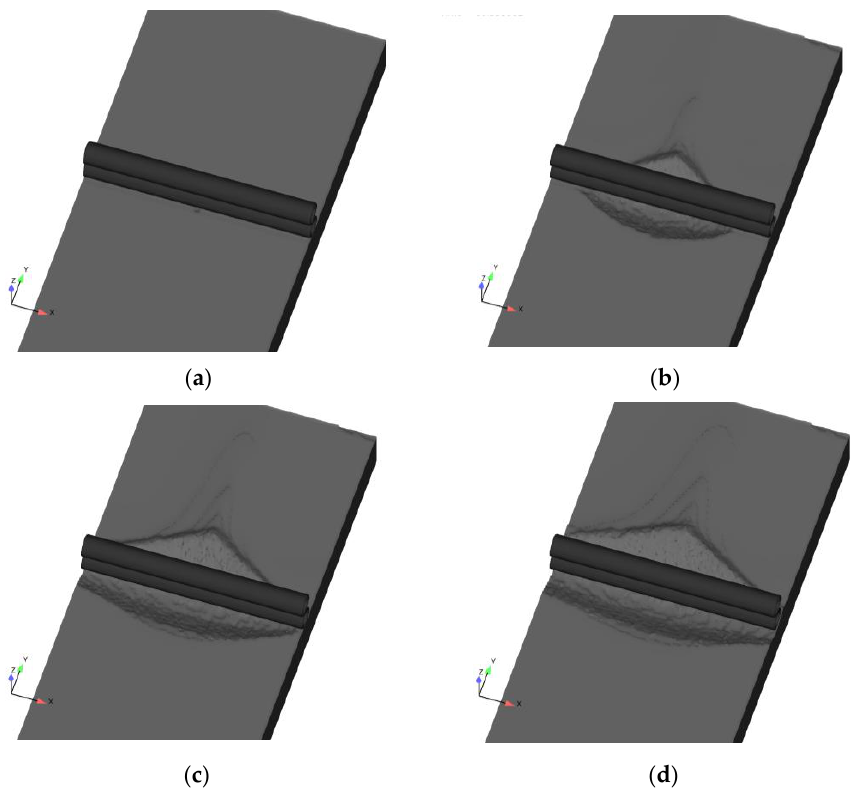
Figure 6. The 3D profiles of scour hole for α = 0°: ( a ) t = 0 s; ( b ) t = 50 s; ( c ) t = 100 s; ( d ) t = 125 s. Figure 7. The 3D profiles of scour hole for α = 0 ◦ : ( a ) t = 0 s; ( b ) t = 50 s; ( c ) t = 100 s; ( d ) t = 125 s.